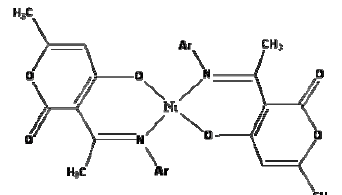
Figure 3. The proposed square planar geometry of Ni(II) complex of ligand L